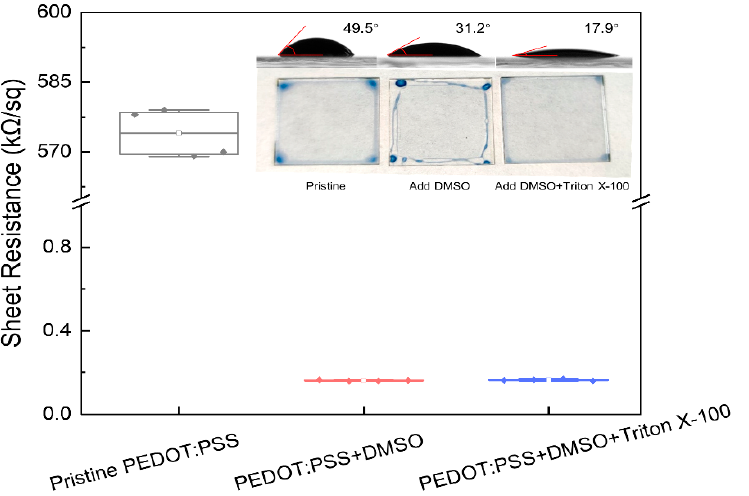
Table 1. Boiling point, surface tension, and viscosity of the solvents and PEDOT:PSS inks with various formulations.